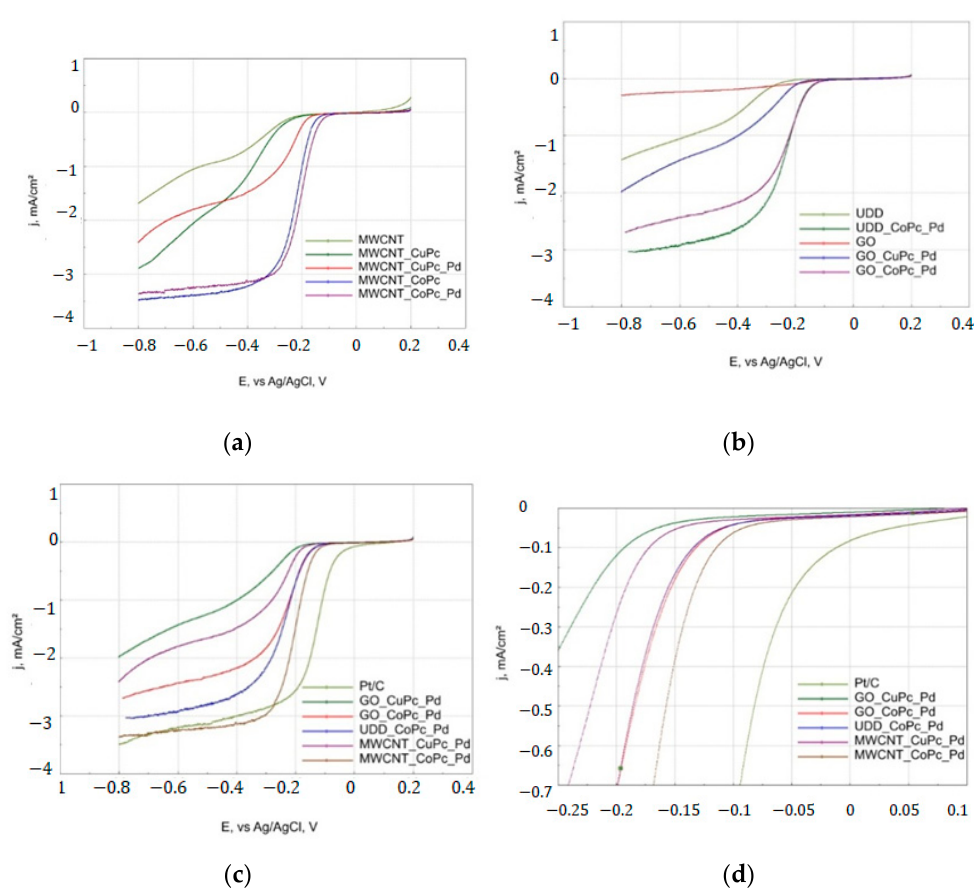
Figure 6. Polarization curves for O 2 reduction on an electrode with various catalysts in an oxygen-saturated KOH solution with a concentration of 0.1 M: potential sweep rate 5 mV·s − 1 , electrode rotation speed 1500 rpm, catalyst loading about 80 μ g·cm − 2 : ( a ) LV of catalysts based on MWCNT, ( b ) LV of catalysts based on GO and UDD, ( c ) LV of the studied catalysts, ( d ) kinetic part of LV of the studied catalysts.